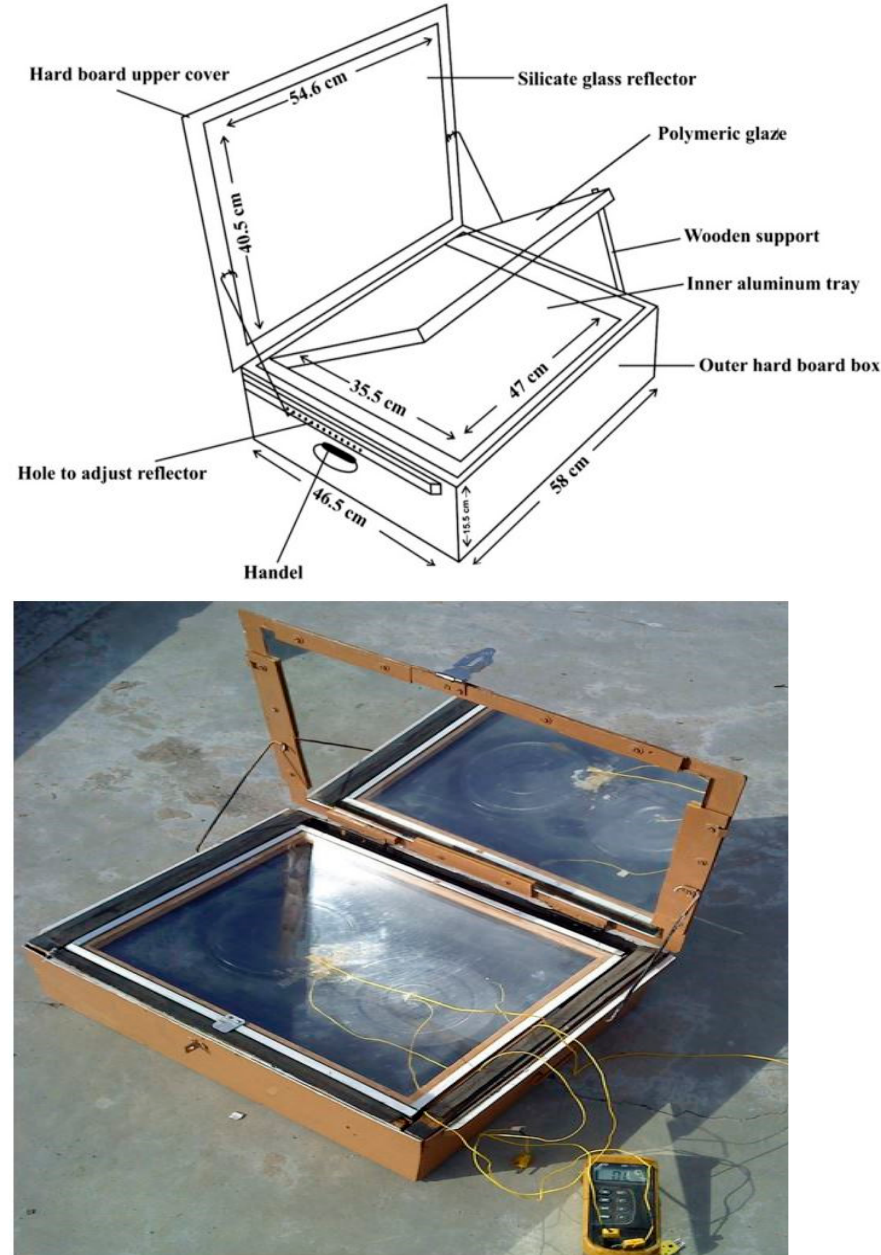
Figure 10. Schematic diagram of solar cooker SFSC. Reprinted/adapted with permission from Ref. [38], 2012, Elsevier.